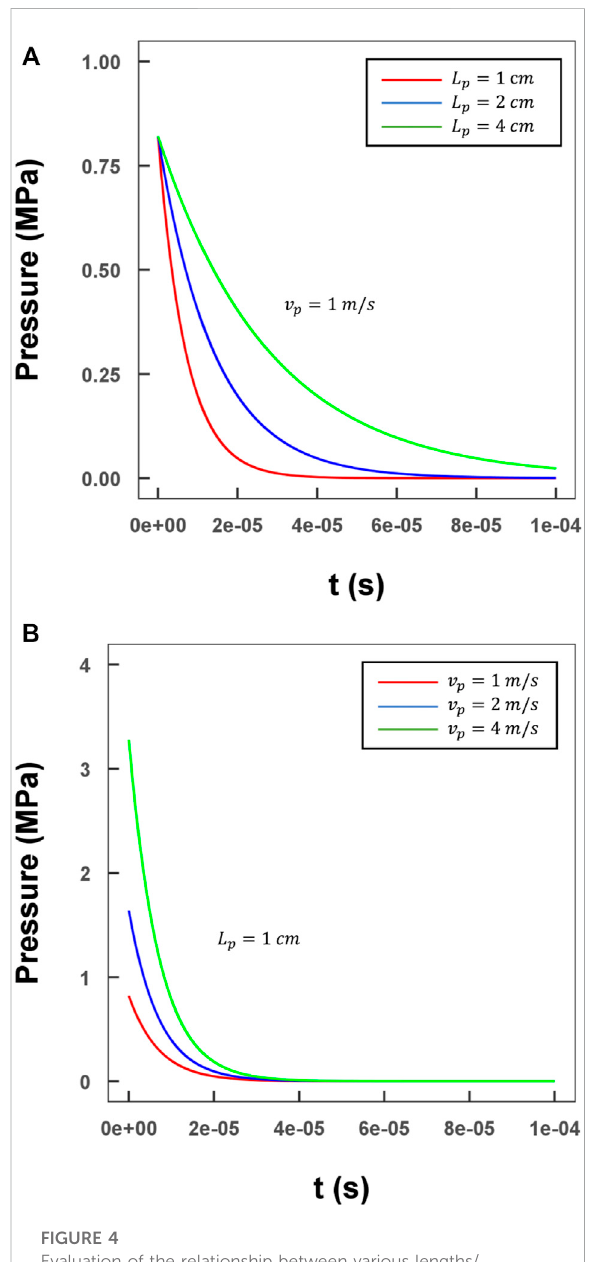
FIGURE 4 Evaluation of the relationship between various lengths/ velocities of the projectile and the input pressure pro fi le. (A) Three different lengths of projectile with a 1 m/s velocity (green line: 4 cm; blue line: 2 cm; red line: 1 cm); (B) Three different lengths of projectile with a 1 cm length (green line: 4 m/s; blue line: 2 m/s; red line: 1